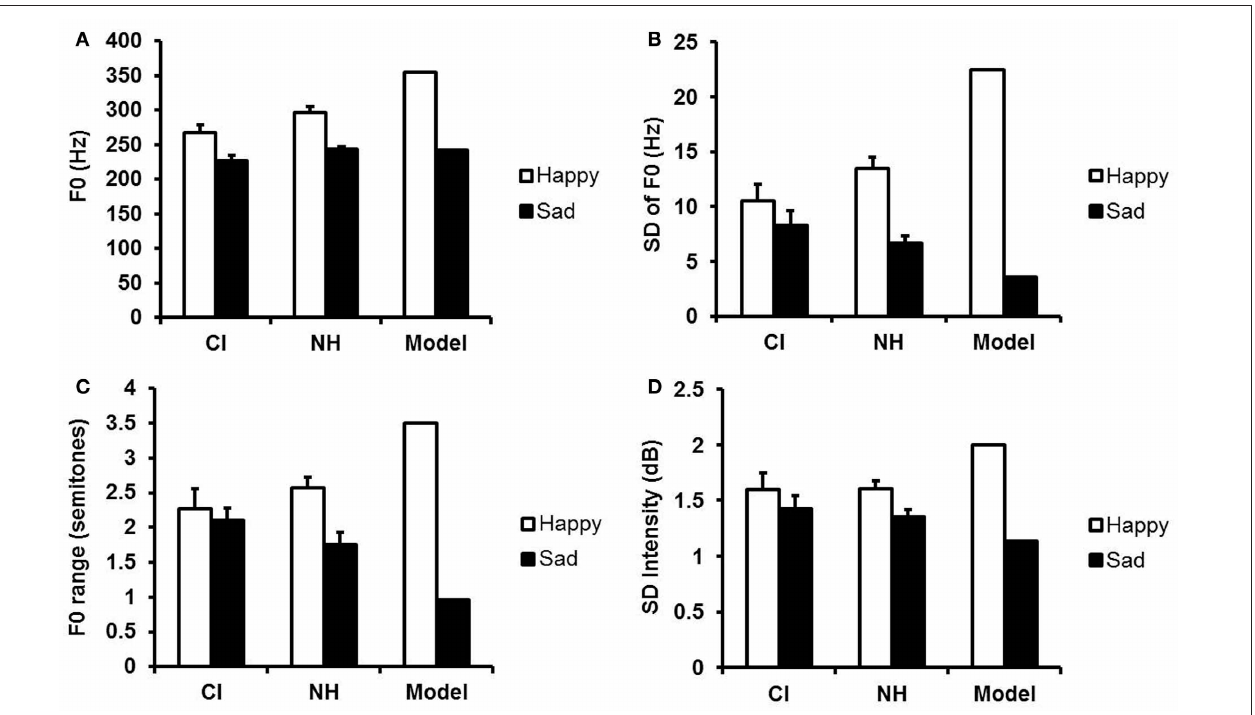
FIGURE 2 | Acoustic features of the happy and sad utterances of child CI users, NH children, and the model. (A) Mean F0 (Hz); (B) mean variability (SD) of F0 (Hz); (C) mean F0 range (semitones); (D) mean variability (SD) of intensity (dB). Error bars indicate standard errors.